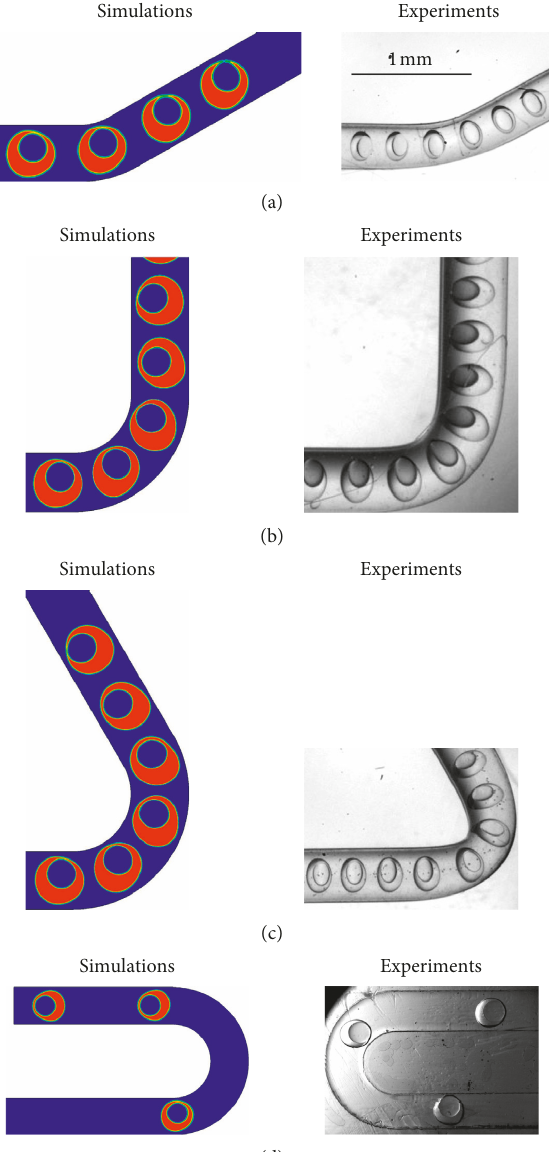
Figure 4: Comparison of the numerical simulation and the experimental results of compound droplet deformation in the curved minichannel: (a) θ � 30 ° ; (b) θ � 90 ° ; (c) θ � 120 ° ; (d) θ � 180 °